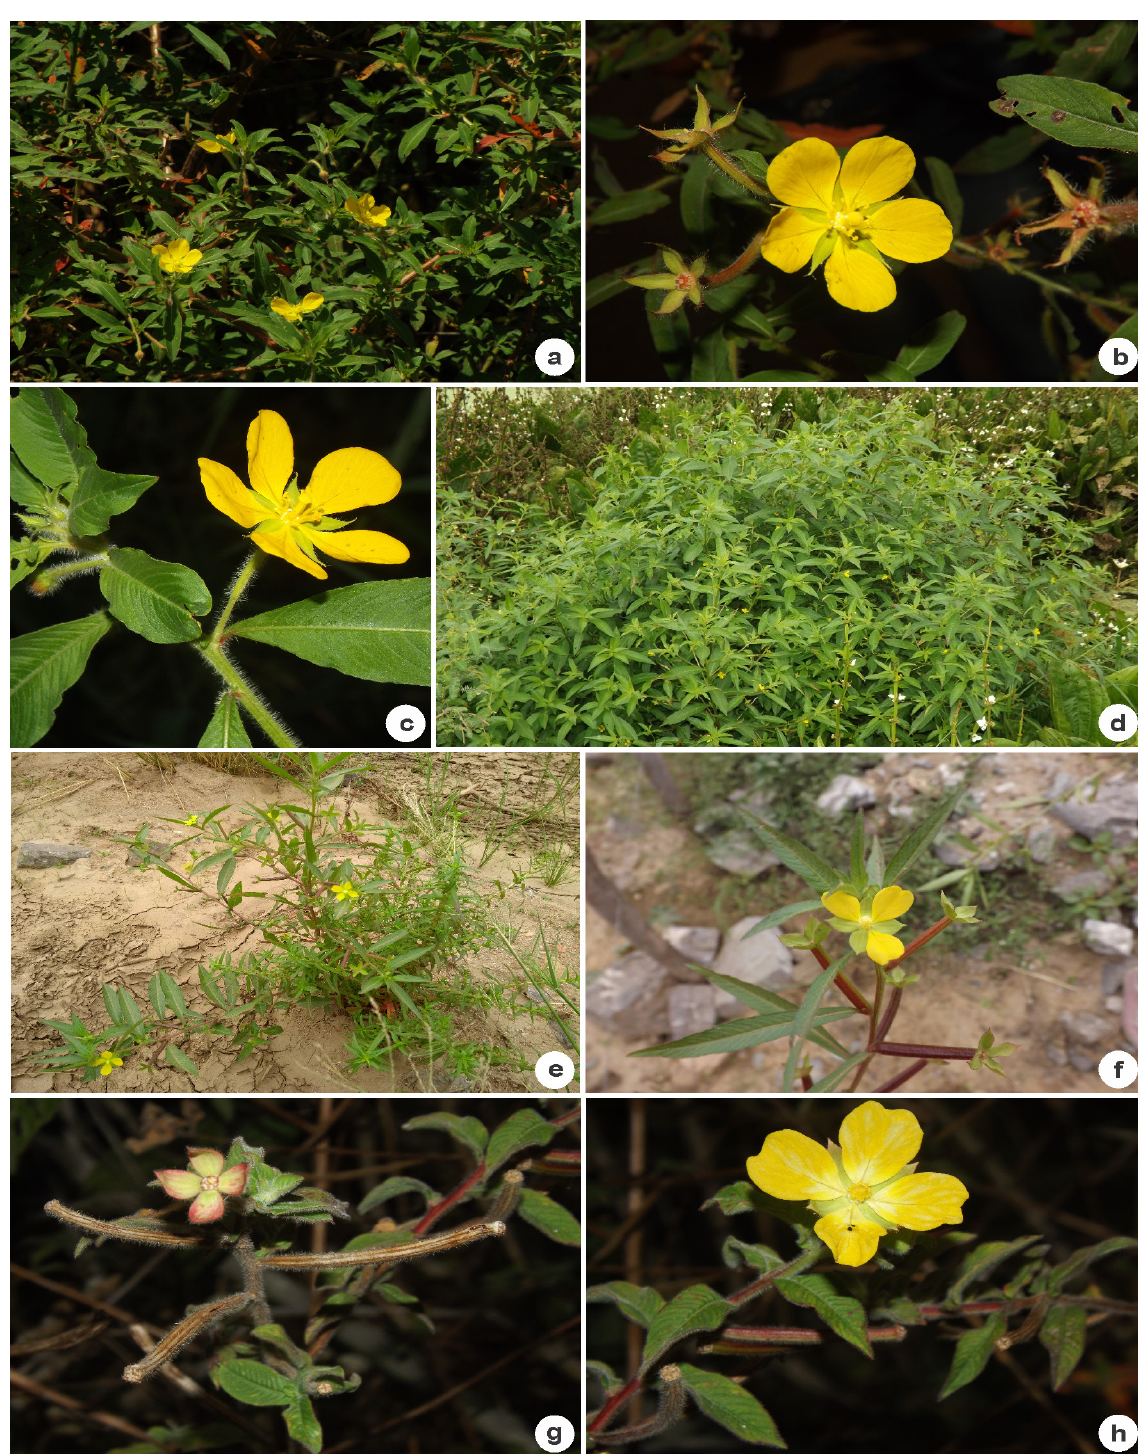
Fig. 7. a – c . Ludwigia leptocarpa (Nutt.) H.Hara. a . Habit. b . Flowering branch. c . Detail of indumentum. – d – h . L. octovalvis (Jacq.) P.H.Raven. d . Population. e . Habit. f–g . Flower. h . Fruits. Photos: A.M.